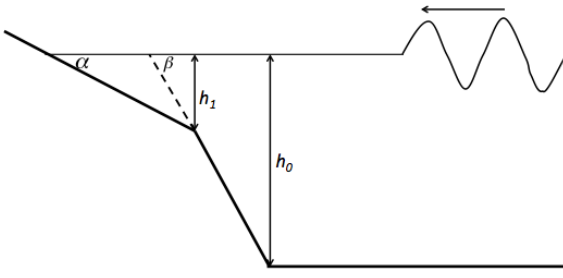
Fig. 12. The three piece-wise linear bathymetry profile. Figure 12. The three piece-wise linear bathymetry profiles.